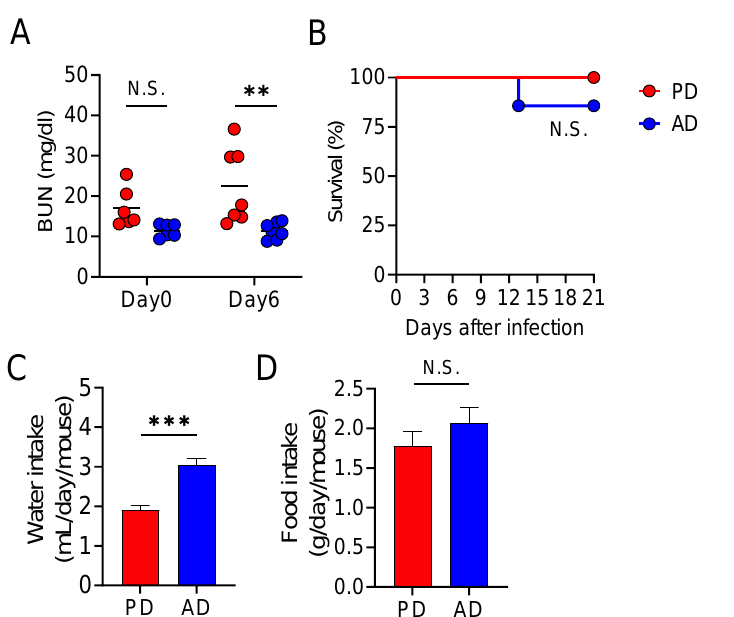
Figure 3. An amino acid-based diet promotes water intake and protects from lethal infectious diarrhea. ( A , B ) Mice fed each diet (PD; regular purified diet, AD; amino acid-based purified diet) were infected orally with Citrobacter rodentium ( n = 9–10 in each group). ( A ) Blood urea nitrogen (BUN) level. Each dot represents an individual mouse and the horizontal bars indicate mean values. ( B ) Mouse survival after peritoneal saline treatment once a day after 6 days. ( C , D ) Mice fed PD or AD for 2 weeks ( n = 9–10 in each group). ( C ) Water and ( D ) food intake. Data are expressed as mean ± SD. Statistical significance was assessed by two-way ANOVA with ( A ) Šídák’s multiple comparisons test, ( B ) log-rank test, ( C ) unpaired Student’s t -test, or ( D ) Mann–Whitney test. ** p < 0.01; *** p < 0.001; N.S., not significant.